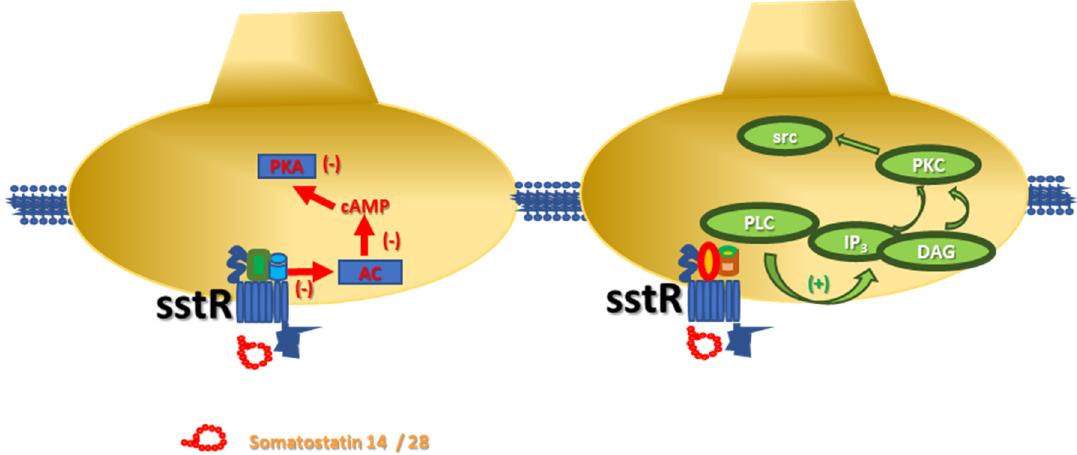
Figure 1. Schematic representation of the intraterminal enzymatic pathways coupled to sst receptors in isolated nerve endings. ( left ) Somatostatin-14/28 binds sst receptors negatively coupled to adenylyl cyclase (AC) and reduces the endoge- nous production of cyclic adenosyl monophosphate (cAMP) and the protein kinase A (PKA)-mediated phosphorylative pathways. ( right ) Somatostatin-14/28 also interacts with sst receptors positively associated to phospholipase C (PLC) then favouring its translocation to the synaptic membranes where the enzyme hydrolyses the phosphoinositides producing inositol trisphosphate (IP 3 ) and diacylglycerol (DAG), which in turn activate protein kinase C (PKC) and cytosolic tyrosine kinases (src).